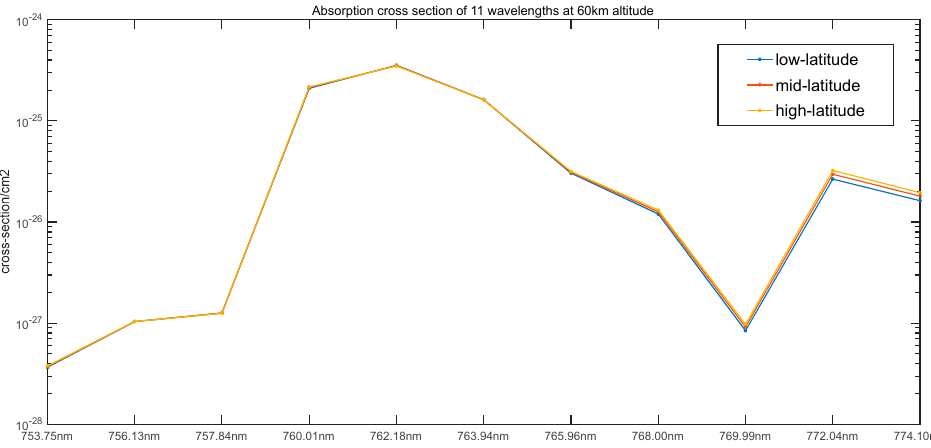
Figure 3. The absorption cross-sections of different wavelengths at 60 km tangent height at different latitudes of low, middle, and high are shown in the figure. The absorption cross-section hardly varies with latitude but changes greatly with the wavelength, of which around 762 nm has a strong absorption line.